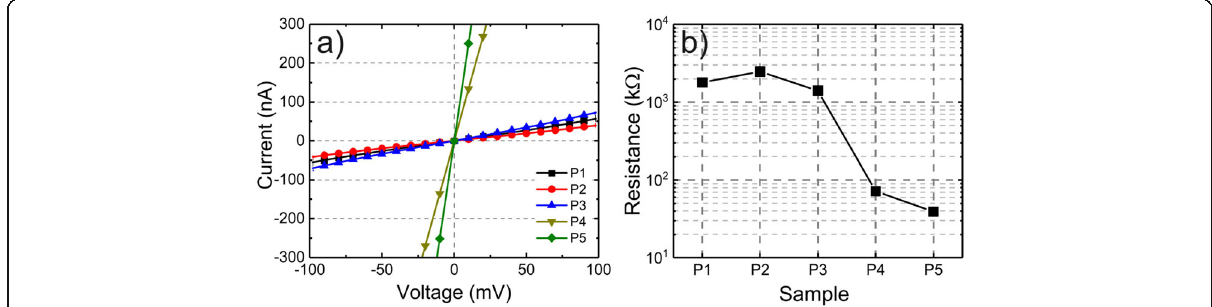
Fig. 2 a IV from P1 to P5 in the 100 mV applied voltage range. b Total channel resistance of the P1 – P5 obtained from linear fit of the IVs in